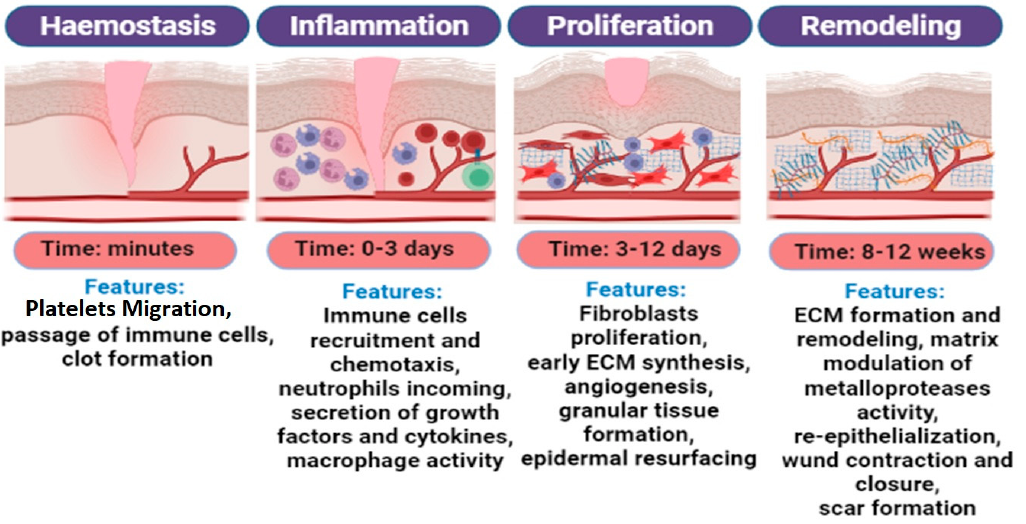
Figure 2. Different phases of wound healing process with their characteristic features.